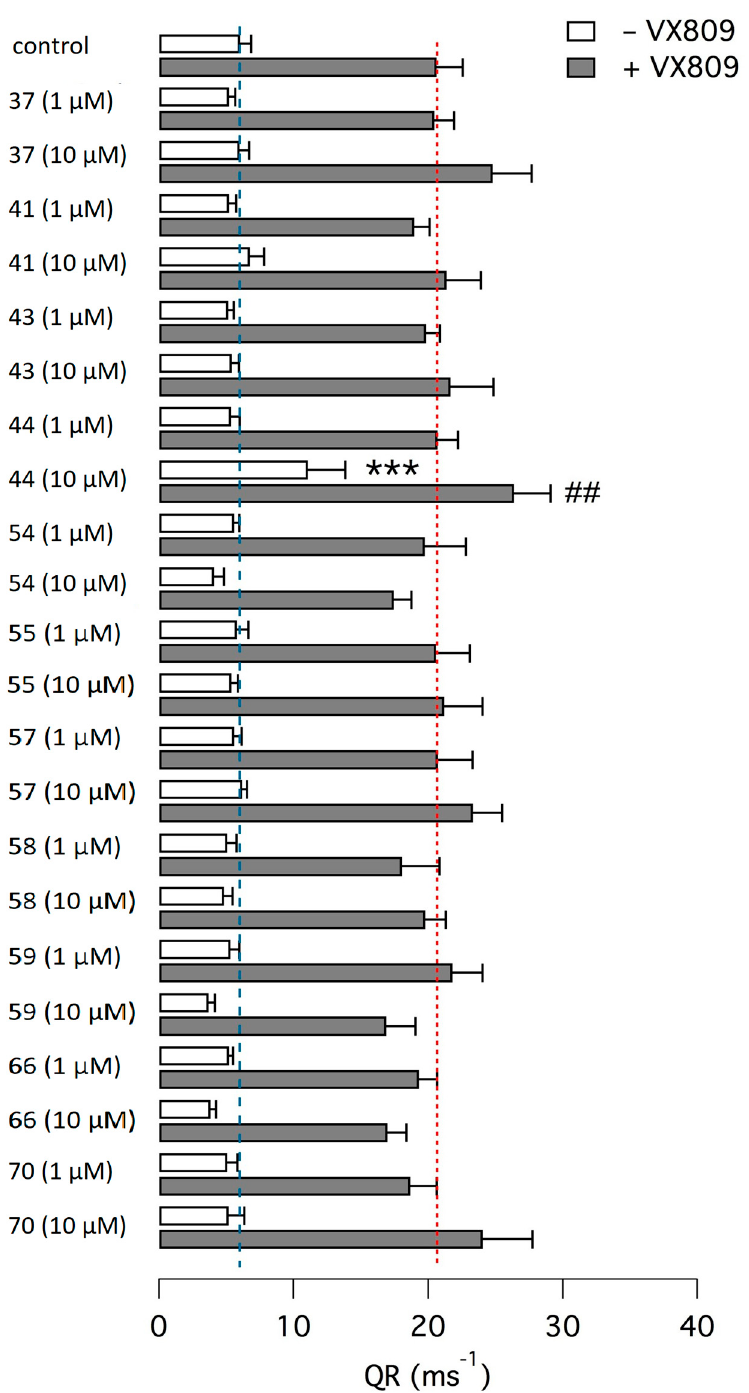
of the isopropyl amide analogue 41 , or to a loss of activity.